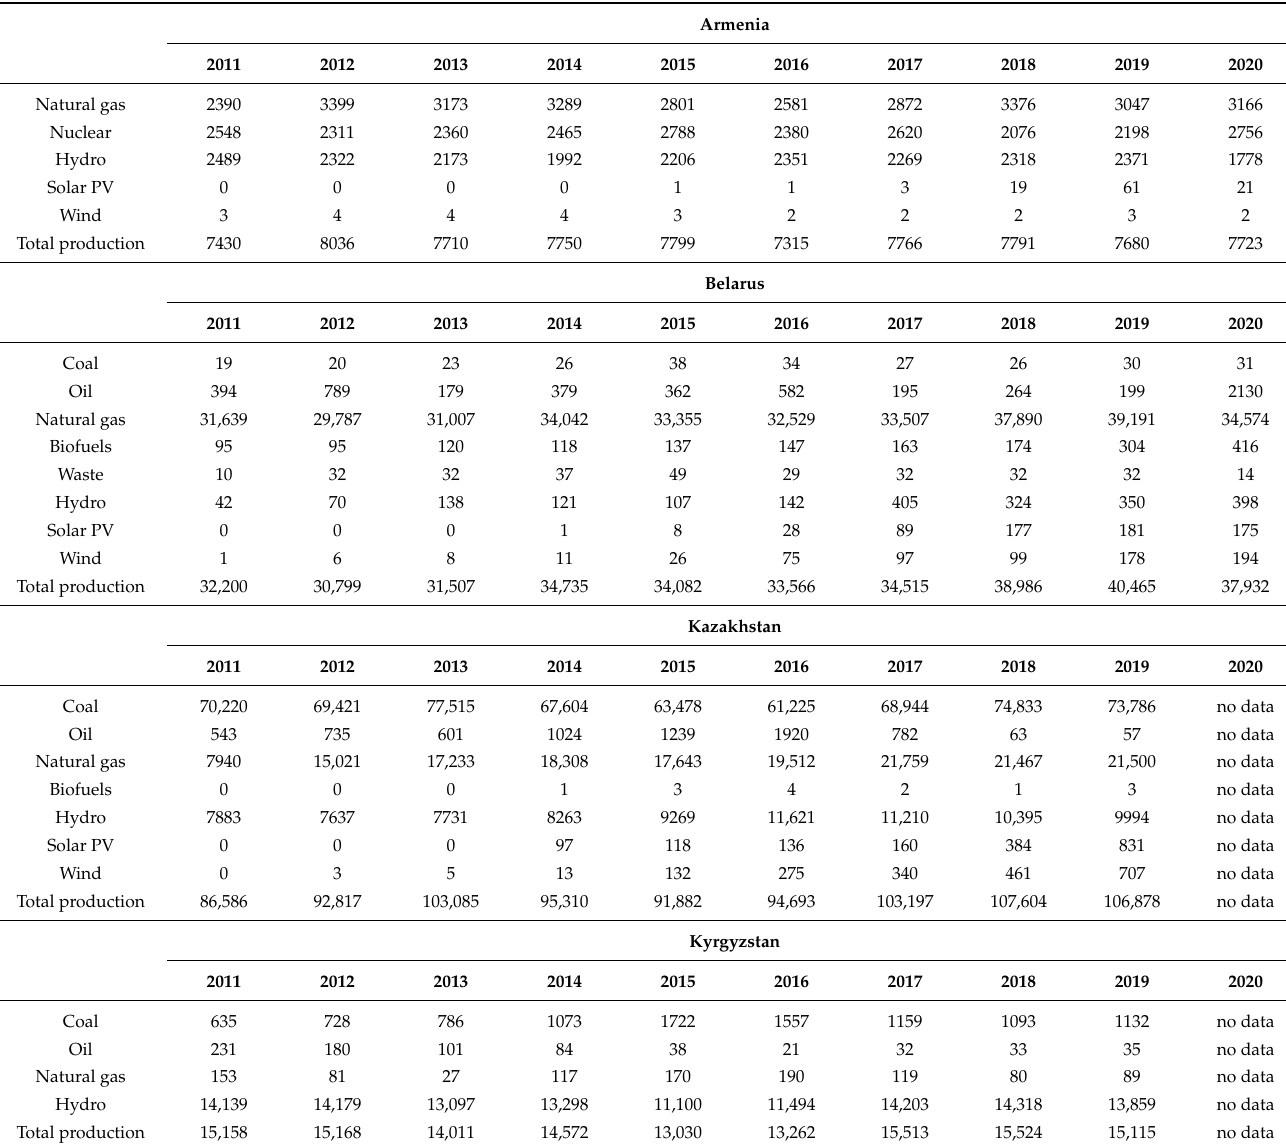
Table 7. Data on energy generation in the EAEU countries,